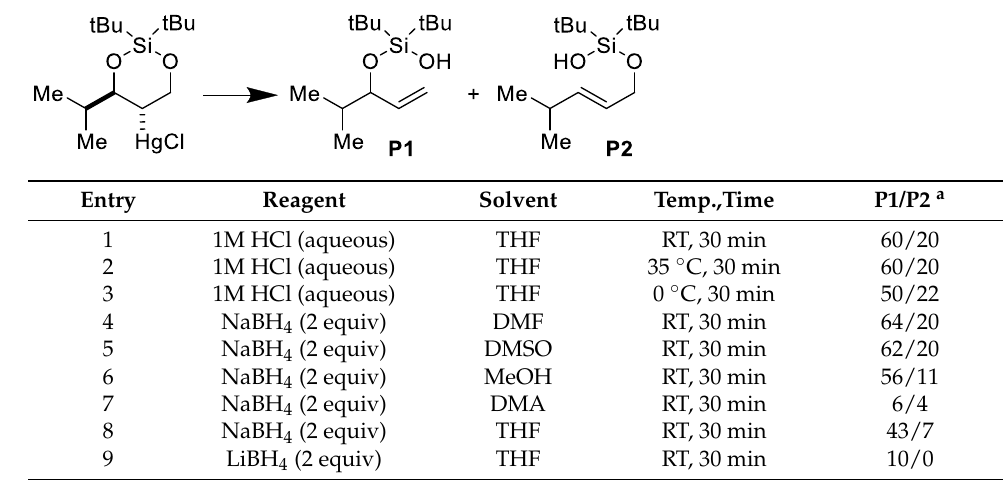
Table 1. Optimization of this allylic rearrangement.